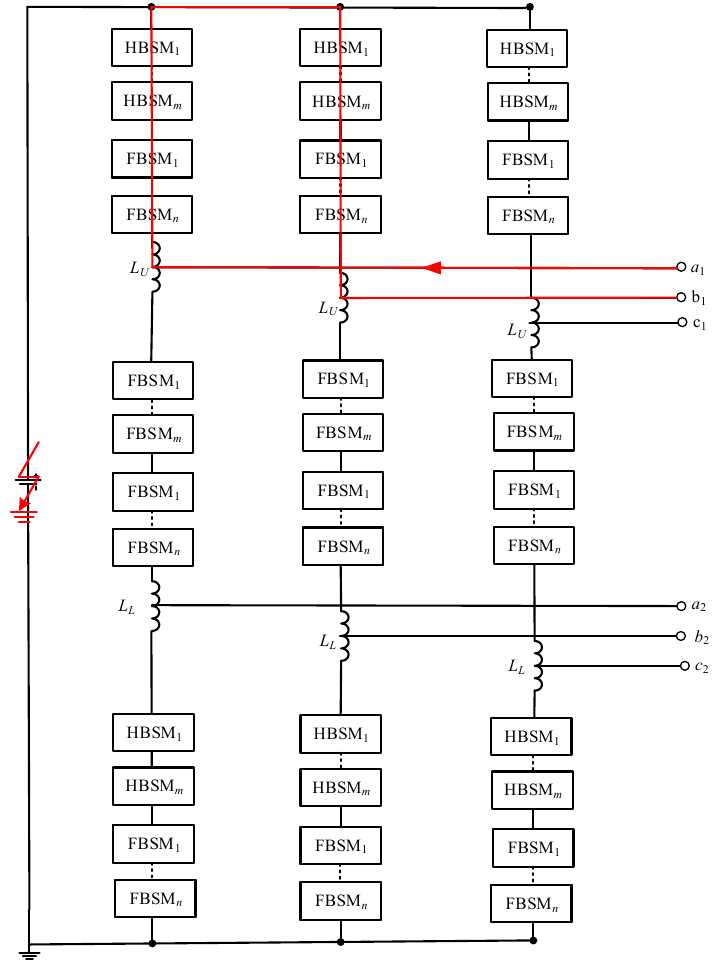
Figure 9. Potential flow path of short-circuit current ( 𝑎 (cid:2869) – 𝑏 (cid:2869) ).